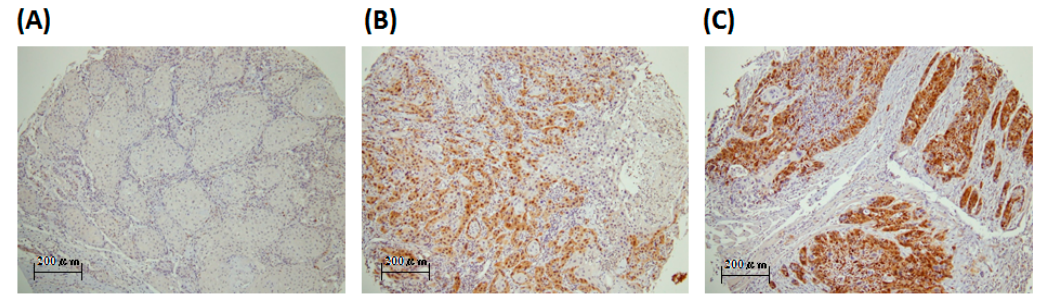
Figure 1. Representative immunostaining of PBK/TOPK in tissue arrays from patients with oral squamous cell carcinoma. PBK/TOPK expression scores were ( A ) 0 (stage 1); ( B ) 100 (stage 4); ( C ) >200 (stage 1), Scale bar = 100× (200 μ m).